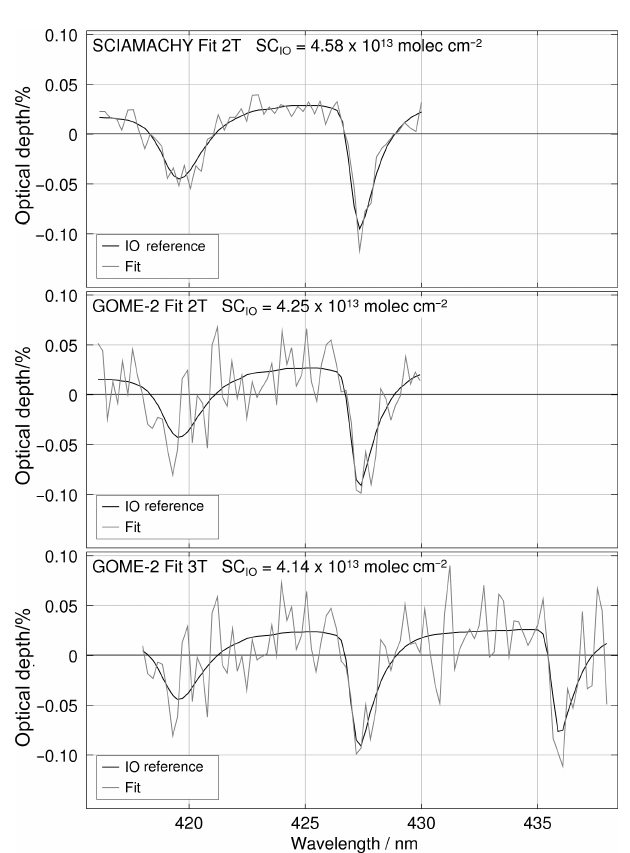
Figure 3. Spectral fitting results from day 11 August 2008 for a collocation between SCIAMACHY (top) and GOME-2A around 55 ◦ N and 220 ◦ E. For GOME-2A, the results from two different fitting windows are shown, using the SCIAMACHY standard IO fitting window (centre) and using a larger spectral window covering three spectral absorption bands of IO (bottom).